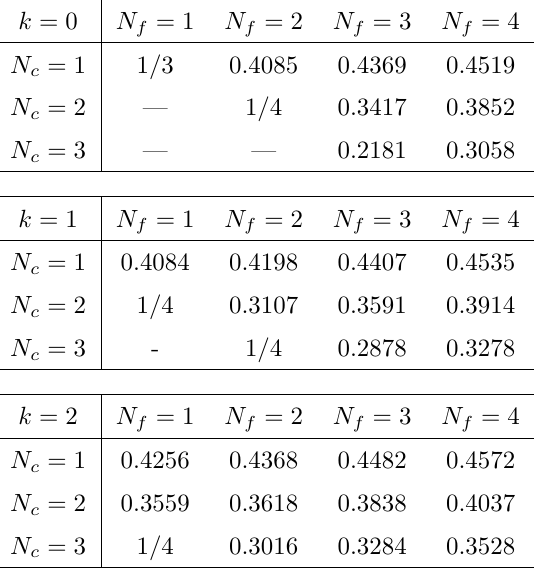
Table 3 . Values of (cid:1) Q which extremize (speci(cid:12)cally, minimize) j Z j for some small values of N c ; N f ; k , obtained numerically. Besides N c = N f = 1 ; 2 and N c = k + N f , none of these values appear to be